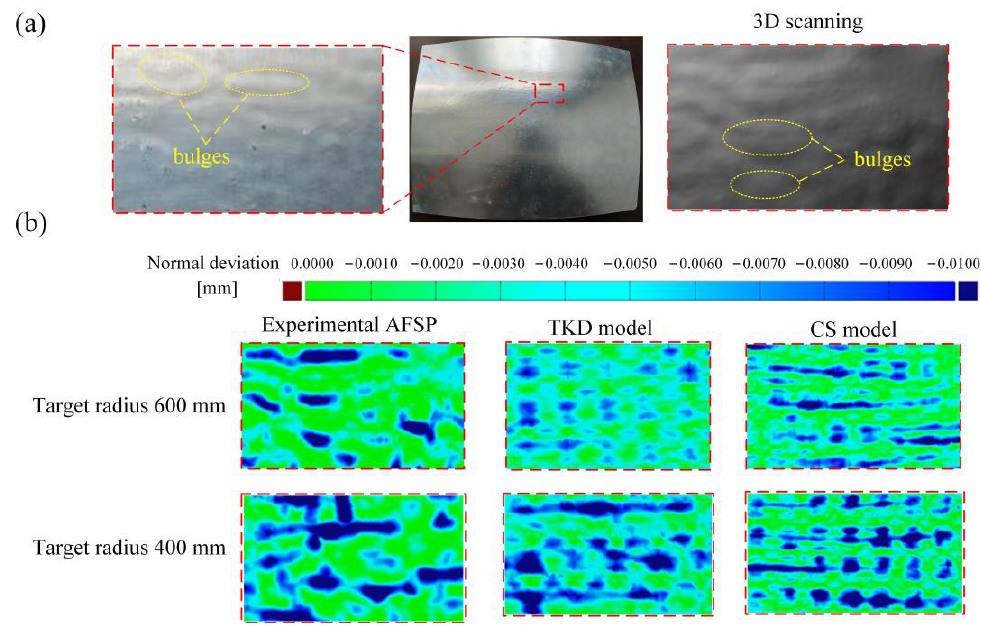
Figure 10. ( a ) Illumination map and 3D scanning diagram of spherical AFSP lower face sheet ( b ) Normal deviation of spherical AFSP surface under different target radii.